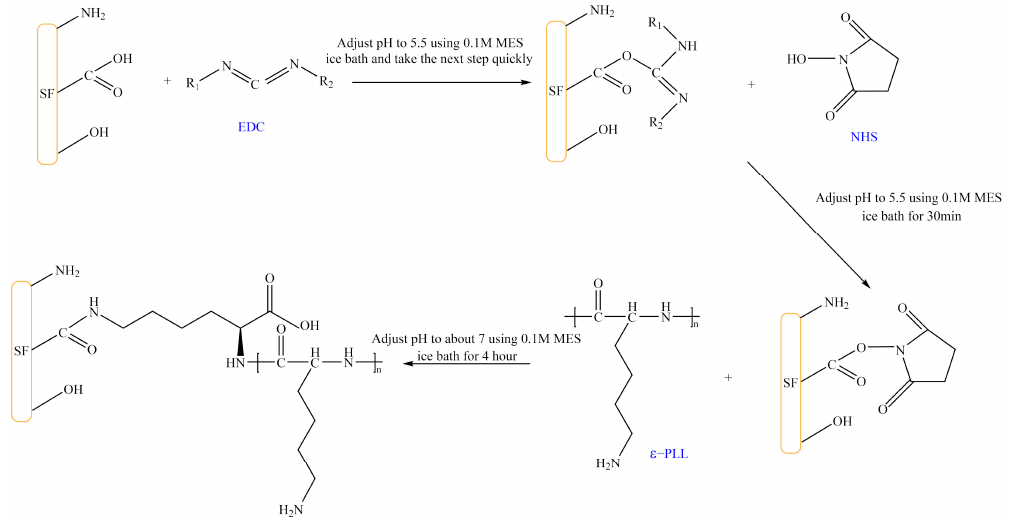
Figure 2. Reaction of SF grafted with ε -PLL. (The solid content of SF and CSF solution is 3 wt.%, EDC concentration is 20 mg/mL, NHS concentration is 15 mg/mL, MES concentration is 0.1 M, ε -PLL concentration is 30